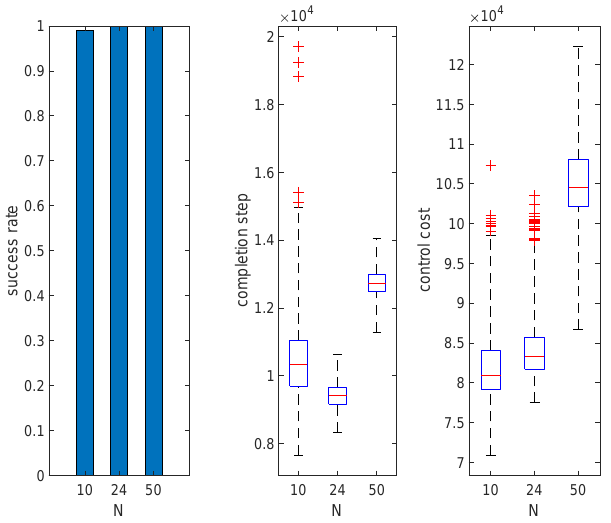
Figure 19. The algorithm performance with respect to the variations of N